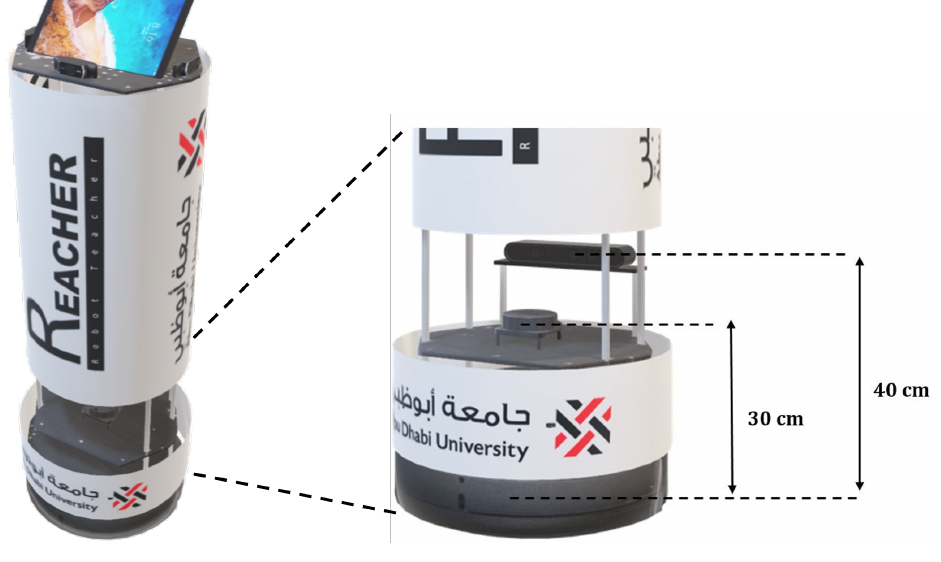
Figure 2. Robot design.